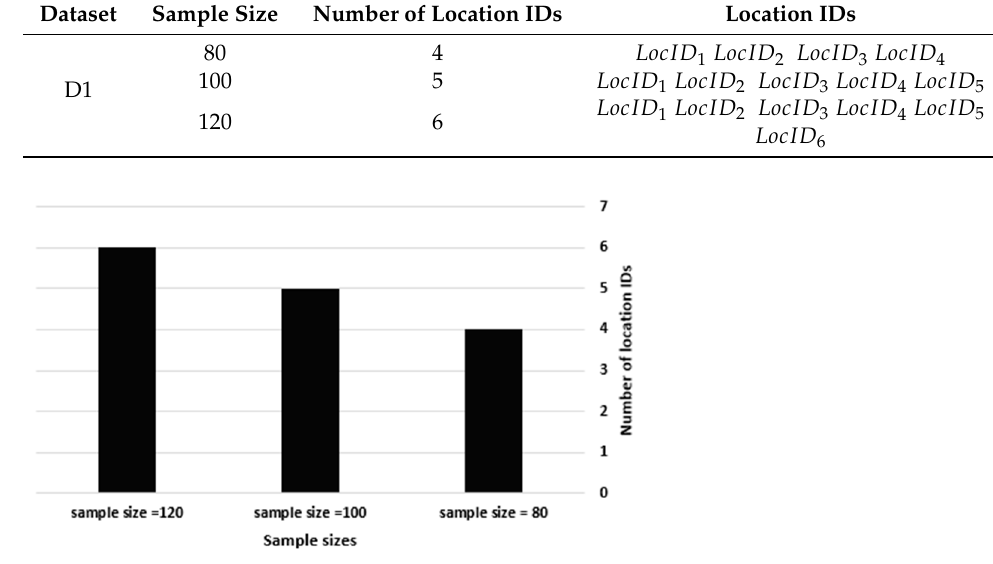
Figure 11. The number of location IDs vs. the sample size.